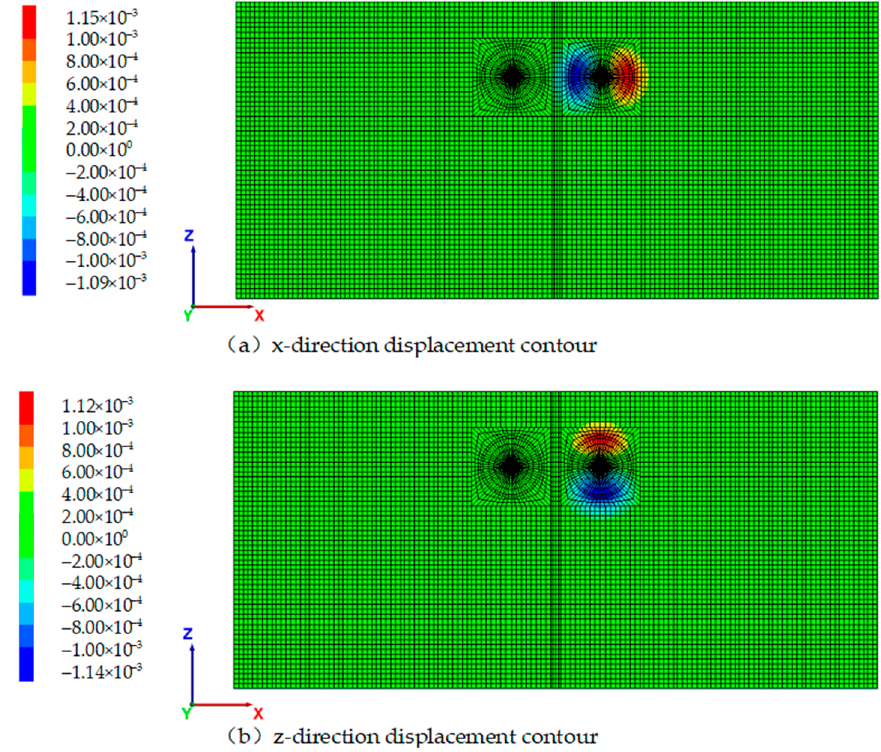
Figure 16. The displacement contour of the portal with the optimization scheme (unit: m).